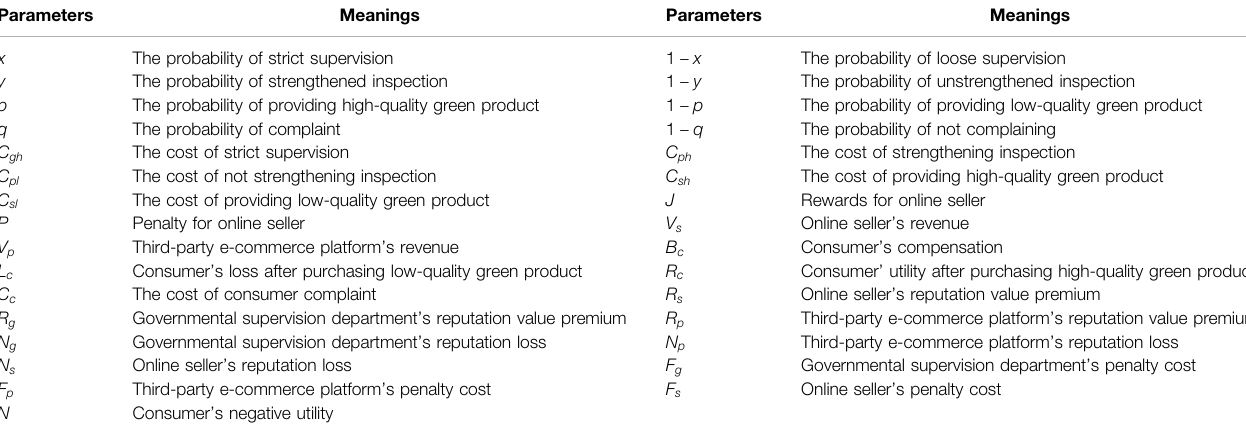
TABLE 1 | Parameters setting and meanings.